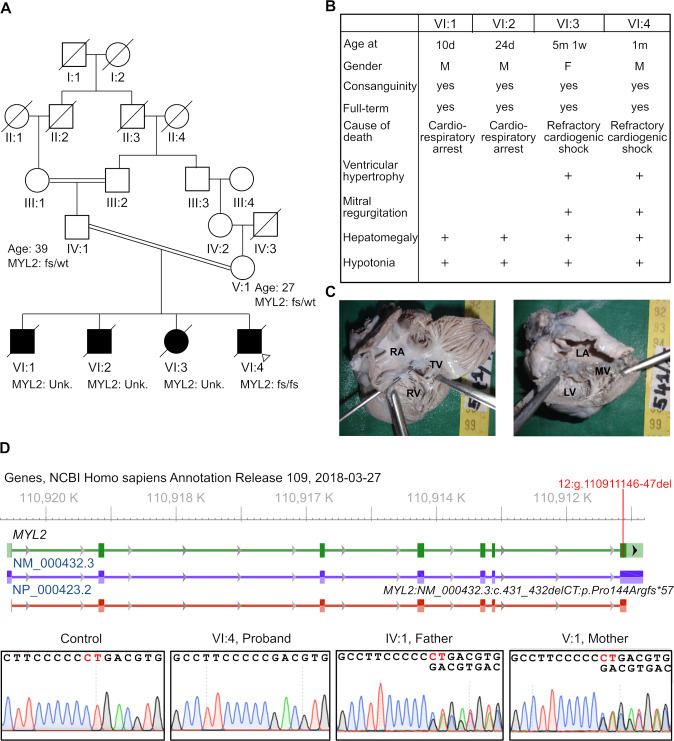
Identification of a novel homozygous frameshift variant in a proband with infantile hypertrophic cardiomyopathy.(A) Pedigree of the family with multiple infant deaths due to early-onset cardiac disease. The consanguinity and age of the parents are also shown. The proband (fs/fs) was homozygous for the MYL2-fs allele while the parents were found to be heterozygous (fs/wt) carriers. The status of the MYL2 allele in siblings is unknown (Unk.). Proband is marked by an arrowhead. (B) Table summarizing key clinical findings of the four siblings (IV:1 –IV:4). (C) Dissection of the post-mortem heart from the proband shows severe biatrial dilatation along with hypertrophy of the right ventricle (left). Severe mitral valve dysplasia and hypertrophy of the left ventricle with a small ventricular cavity is also noted (right). RA- right atrium; TV- tricuspid valve; RV- right ventricle; LA- left atrium; MV- mitral valve; LV- left ventricle (D-top) The genomic locus of the MYL2 gene shows the frameshift variant identified in the proband (highlighted in red), which is located in the last exon of the gene. (D-bottom) Sequence chromatograms from Sanger sequencing of control (MYL2 wt), the proband (homozygous fs variant: MYL2:NM_000432.3:c.431_432delCT) and the parents (heterozygous fs).